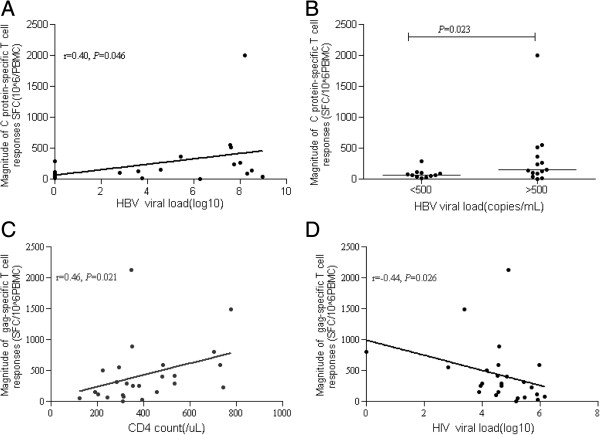
Correlation of various HBV and HIV associated variables. (A) Correlation of HBV viral load and HBV-specific T-cell responses elicited by chronic HBV patients co-infected with HIV. (B) Comparison of HBV-specific T-cell responses induced by HBV-infected patients with HIV coinfection grouped by HBV viral load (<500 copies/mL or >500 copies/mL). The relation of CD4 count (C) and HIV viral load (D) on gag-specific T-cell responses elicited by chronic HBV patients co-infected with HIV.